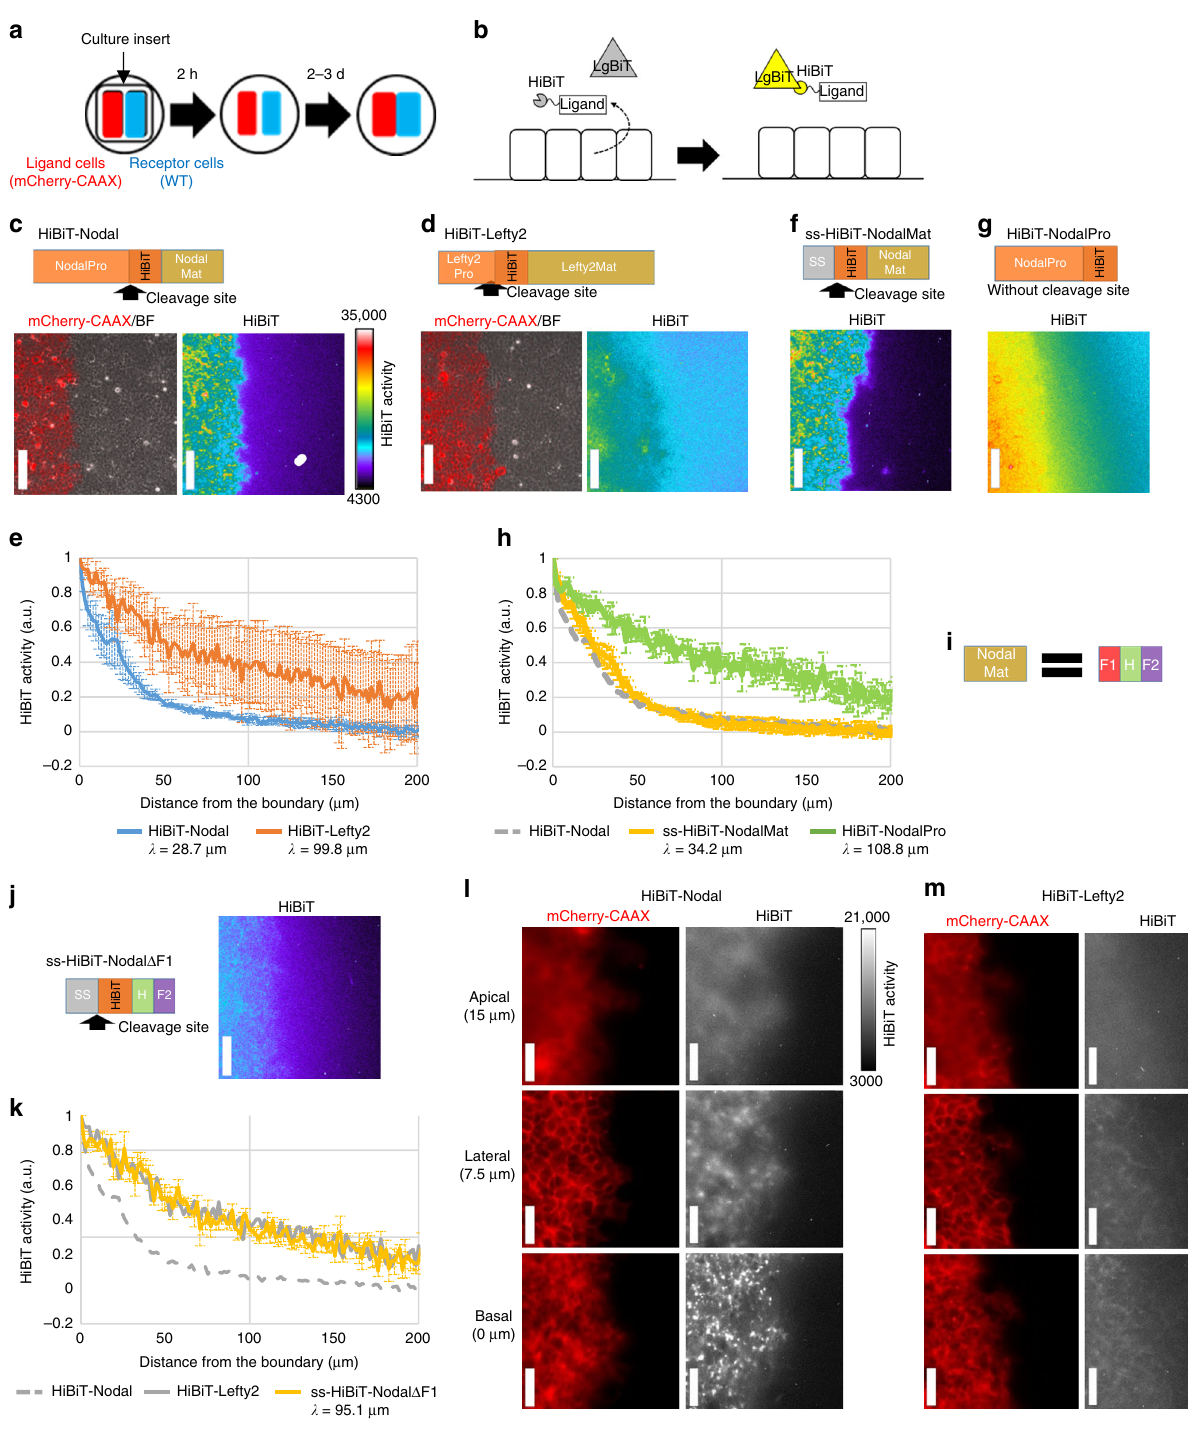
indicating that the effective range of Nodal is 3.5 times LgBiT and substrates (Supplementary Fig. 5a). To compare the distribution ranges of different proteins, we fi tted the normalized distribution to a simple exponential function, exp( − x / λ ). The ffiffiffiffiffiffiffiffiffi p characteristic distance λ is the point where the signal drops to 1/e, and λ also represents D = γ , where D is the effective diffusion coef fi cient and γ is the degradation rate 35,36 . In the case of HiBiT- Nodal, λ = 28.7 µm (Fig. 2e), suggesting that the effective range of Nodal is only one or two cells since the cell size is 10 – 20 µm. By contrast, HiBiT-Lefty2 displayed much wider distribution where the signal gradually decreased (Fig. 2d), and λ = 99.8 µm (Fig. 2e),